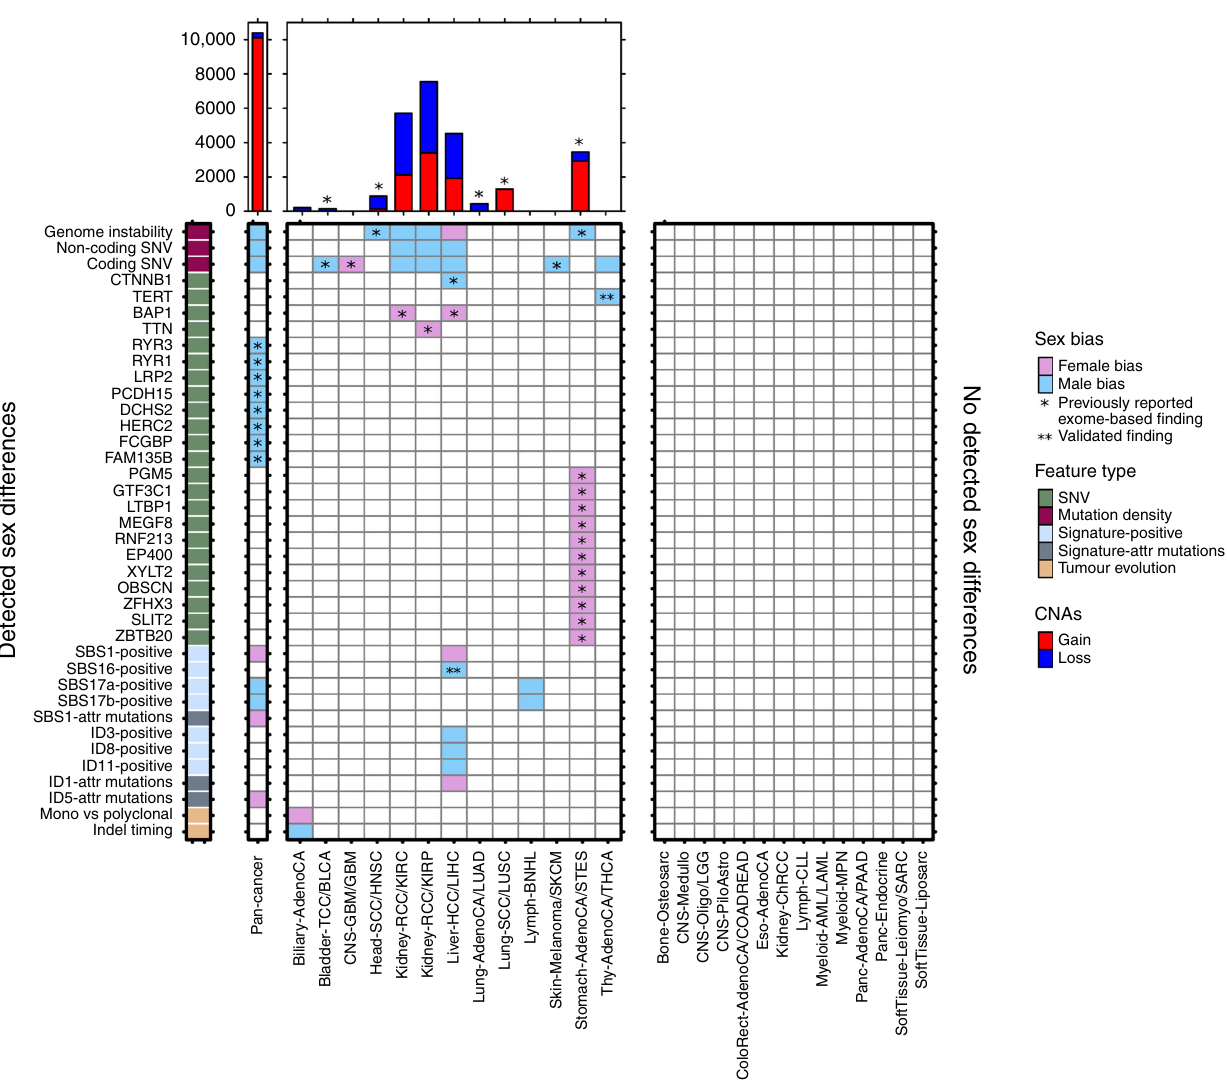
Fig. 4 The landscape of sex differences in cancer genomics. Summary of genomic features found to be sex-biased in pan-cancer analysis or in speci fi c tumour subtypes. Results from both PCAWG and TCGA analyses are shown. Direction of sex-bias is shown in coloration denoting which sex has higher or more frequent aberration of the genomic feature. Top plot shows union of genes found to be involved in sex-biased CNAs. Starred indicate fi ndings exclusively from exome sequencing data ( n = 7131), un-starred indicate fi ndings from PCAWG data ( n = 1983), and double-starred indicate fi ndings also described in other